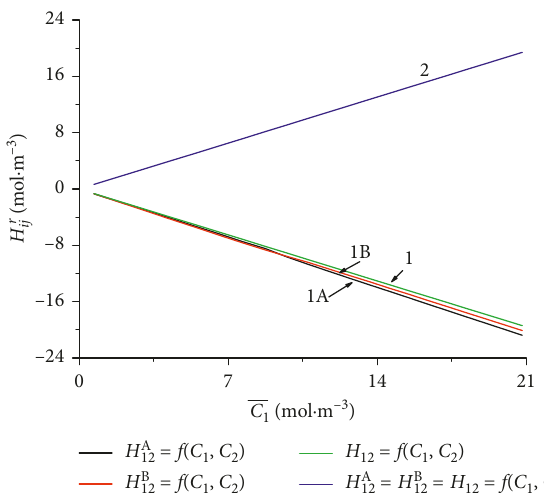
f ( C 1 , C 2 13 (cid:31) f ( C 1 , 13 (cid:31)